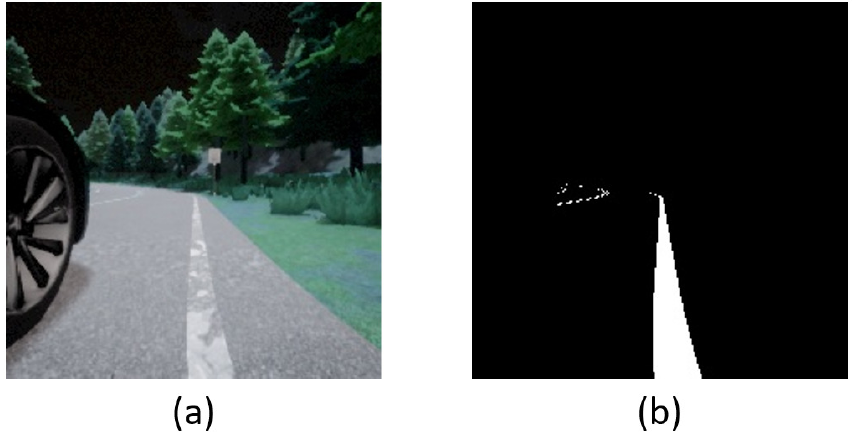
Figure 5. An example of side driving vision to obtain lane lines: ( a ) Original; ( b )